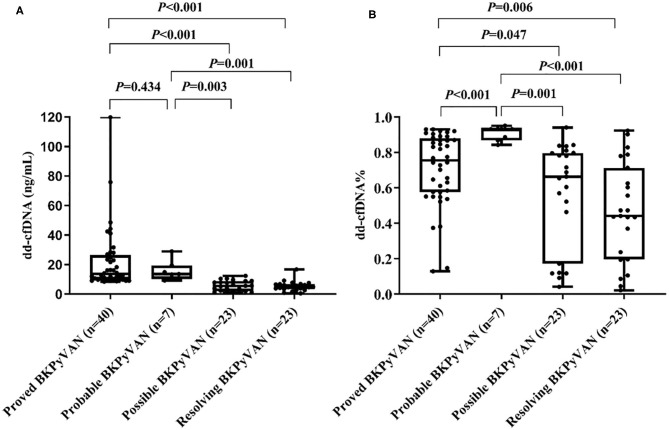
Box plots of (A) urine dd-cfDNA and (B) urine dd-cfDNA% of the four groups.